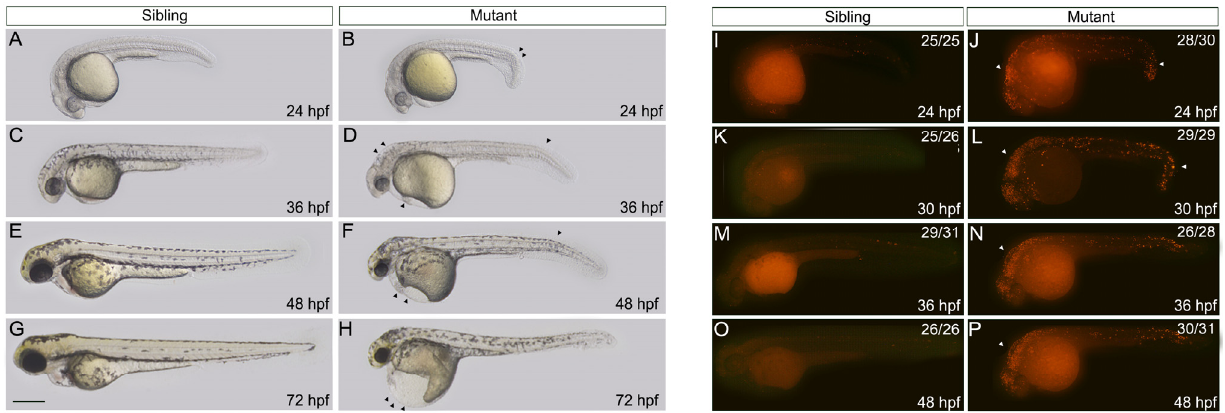
Figure 2. The embryos with nop56 deficiency display morphological abnormalities due to increased apoptosis. ( A – H ) The phenotypes of wildtype siblings and nop56 -/- mutants. At 24 hpf ( A , B ), a minor curved tail (arrowhead) and slightly slower development were seen in the mutants. At 36 hpf ( C , D ), the ventricle and cerebellum of the mutants showed obvious bulging, and malabsorption of the yolk led to a slight swelling of the yolk sac, and pigmentation was delayed. The narrow eyes and edema in the heart were more apparent at 48 hpf ( E , F ). At 72 hpf ( G , H ), the mutants showed cardiac edema, a severely deformed trunk and yolk, and a smaller head and eyes. ( I – P ) The apoptosis level of the siblings and mutants at 24 hpf ( I , J ), 30 hpf ( K , L ), 36 hpf ( M , N ), and 48 hpf ( O , P ), determined using TUNEL staining. The arrowhead indicates apoptotic signals. All scale bars represent 500 µ